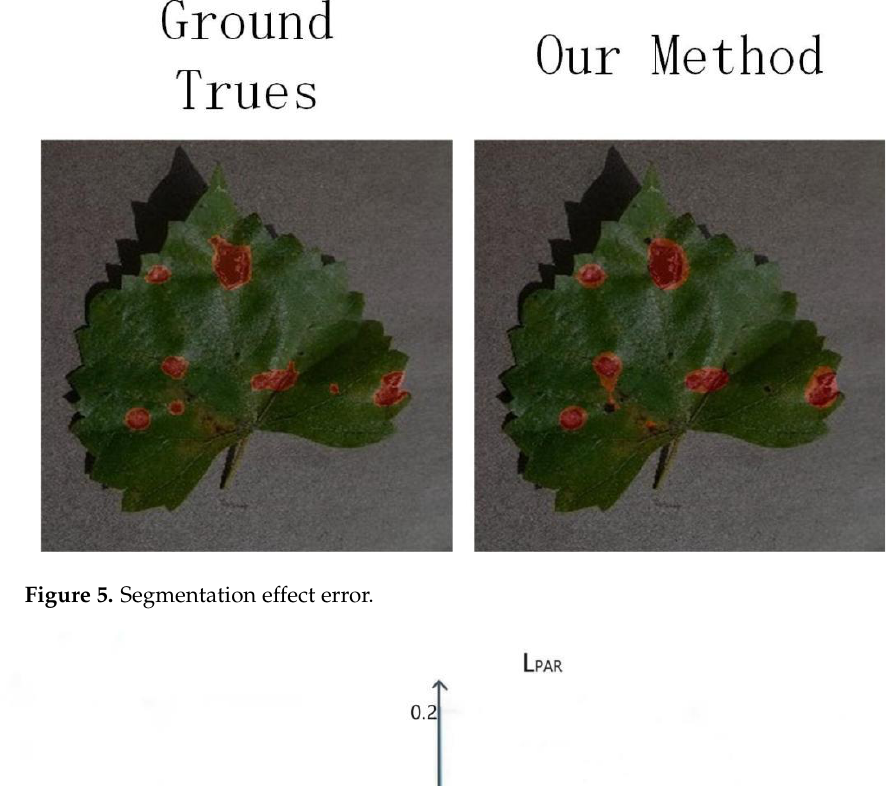
Figure 5. Segmentation effect error.